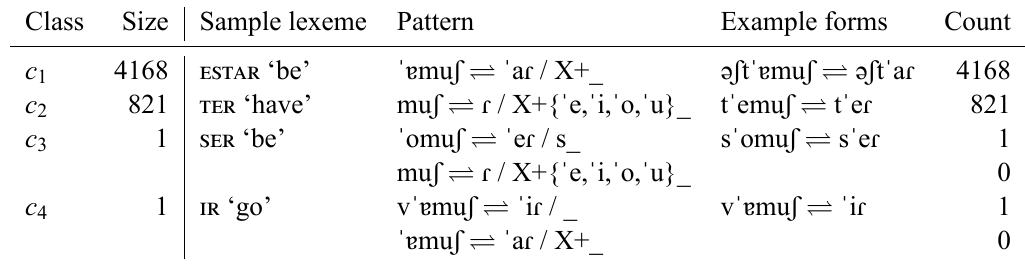
Table 12: Classes of PRS.IND.1PL for prediction of